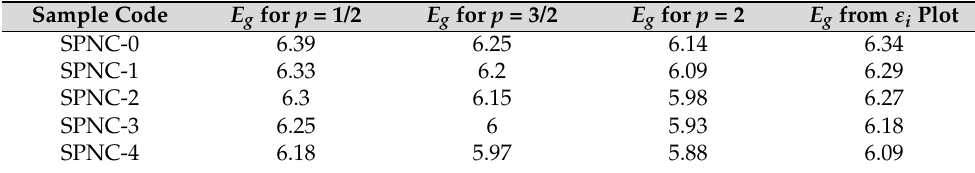
Figure 8. Variation in dielectric loss as a function of photon energy for pure and CeO 2 -doped PVA samples.